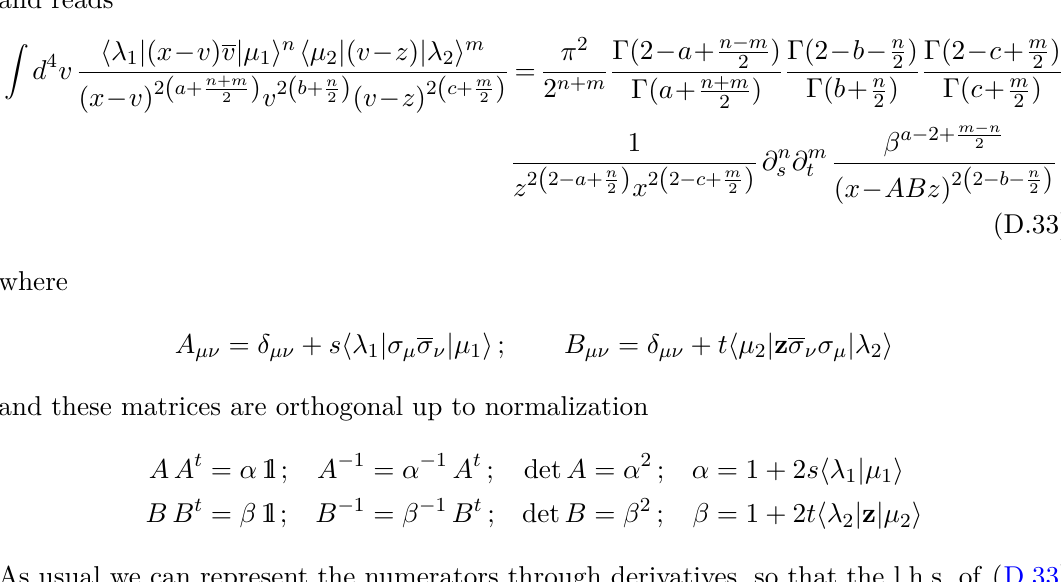
Figure 16 . The four steps of the proof of the exchange relation (D.25), from the left to the right. Initial expression (1); insertion of identity in the space of spinors as R opening of the triangle on the right side into a star with integration in z 0 (3); computation of the star integral in z